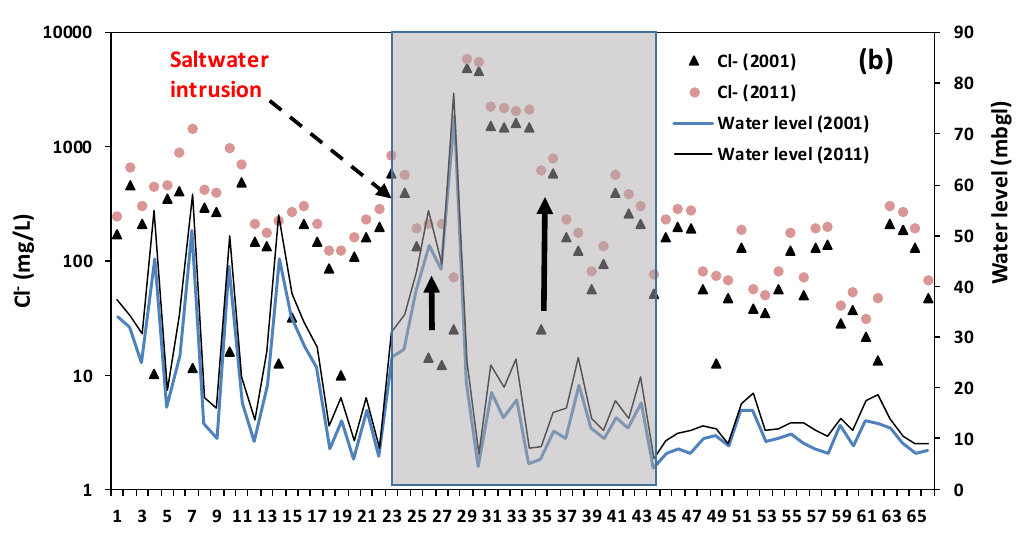
Figure 6. Spatial distribution of ( a ) NO 3 − and ( b ) Cl − in the groundwater with relation to water level.